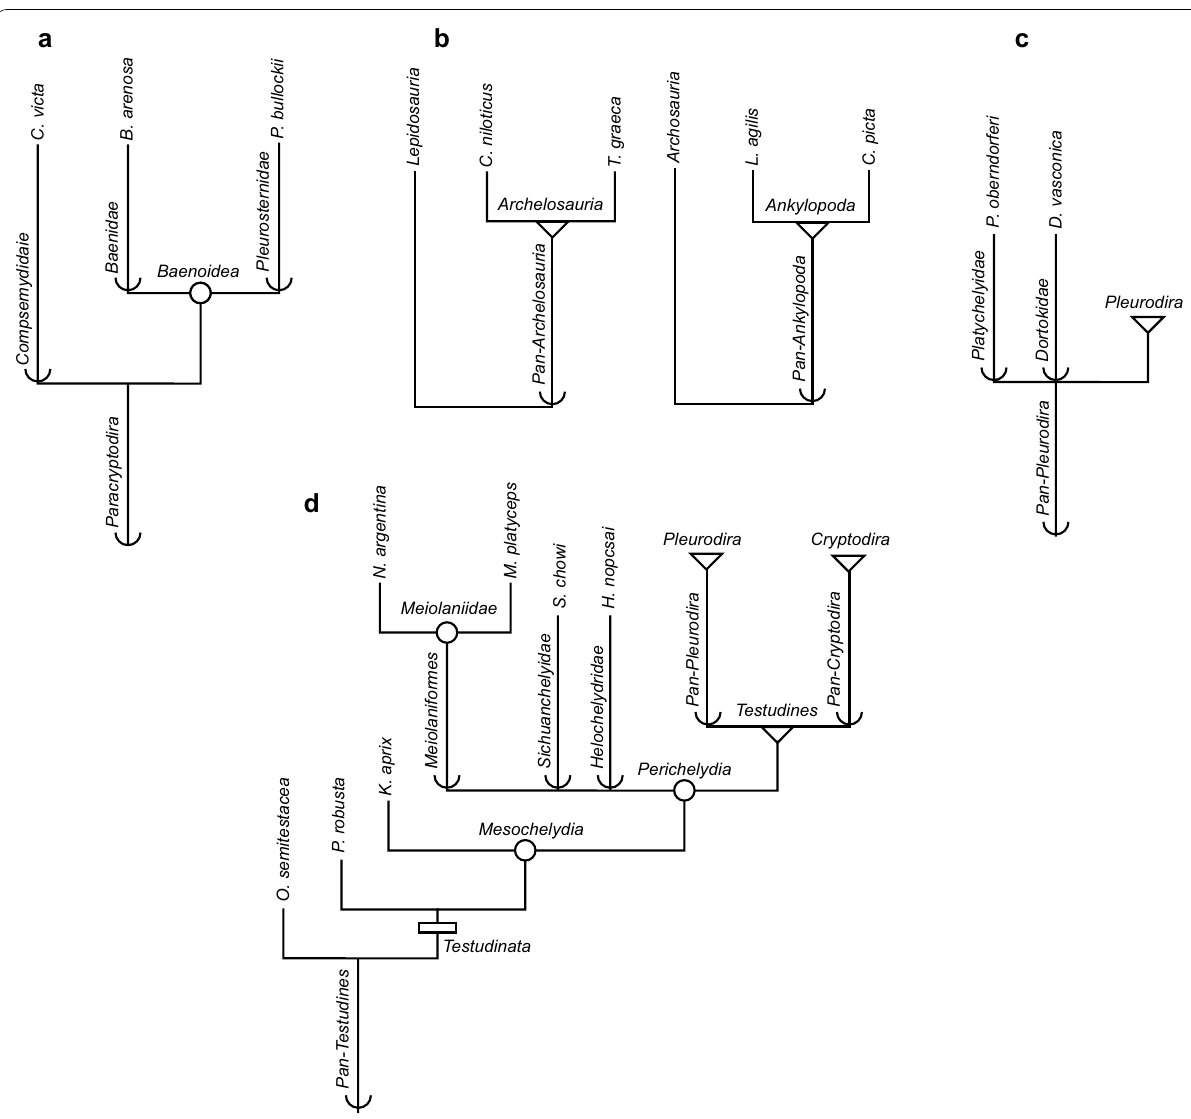
Fig. 1 Simplified diagrams that highlight the proposed name usage of clade names within a Paracryptodira , b Archelosauria and Ankylopoda , c Pan-Pleurodira , and d